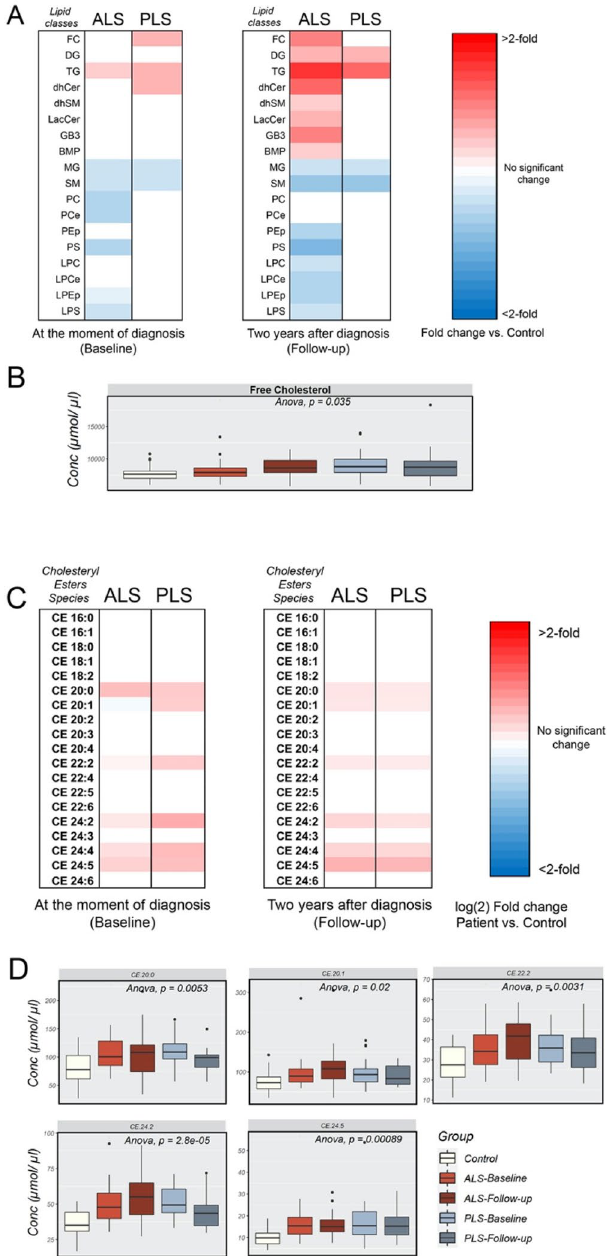
Figure 4. Representation of changes in the main categories of lipids in and cholesteryl esters species in plasma from ALS and PLS patients compared to controls. ( A ) Heat map representation of the most significant fold- changes in the concentration of every class of lipids in plasma from ALS patients compared to controls at the beginning of the study (baseline) and 2 years after (Follow-up). (n = 40 ALS, n = 26 PLS samples and 28 controls analyzed in triplicate. *< 0.05; **< 0.01. T-Test). ( B ) Graph representations of FC concentrations in ALS and PLS plasma. One-way ANOVA. P values are indicated. (C) Heat map representation of the most significant fold- changes in the concentration of cholesteryl ester (CE) species in plasma from ALS and PLS patients compared to controls at the beginning of the study (baseline) and 2 years after (Follow-up) ( D ) Graph representations of the average concentration of CE species in ALS and PLS plasma. One-way ANOVA. P values are